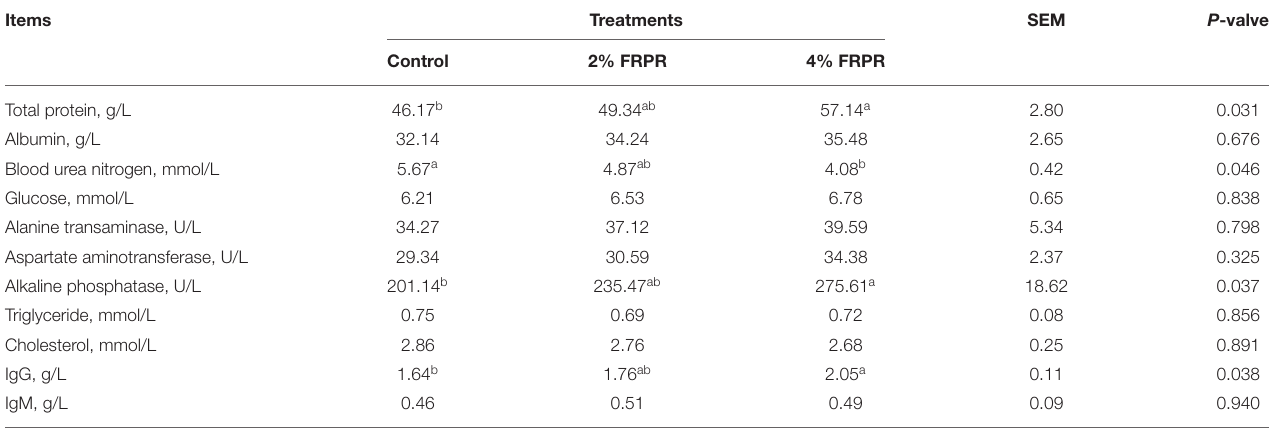
TABLE 5 | Effects of maternal dietary supplementation with FRPR on serum biochemical parameters in the offspring piglets 1 .